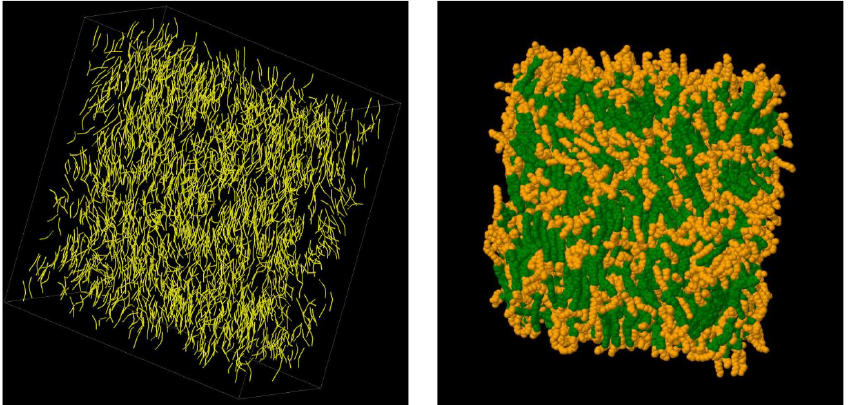
Figure 2. Simulation snapshots of 2048 molecules from the nematic phase of the bent-core mesogen C5-Ph-ODBP-Ph-OC12 at 480 K. ( Left ): Line drawing representation of the molecular bent core within the nematic phase. ( Right ): space-filling representation of C5-Ph-ODBP-Ph-OC12 molecules in the nematic phase showing molecular cores in green and alkyl tails in gold. The snapshot shows the beginnings of microphase separation between cores and tails that occurs in a pretransitional region before the phase transition to a DC phase at lower